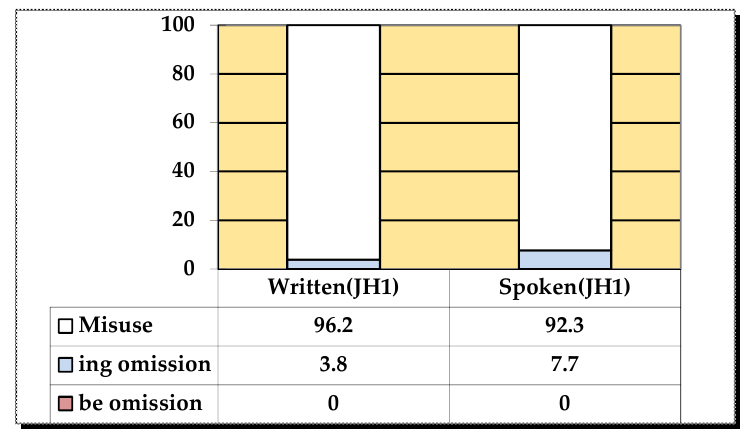
Figure 6. Misuse of bare verbs and 3SG − s in auxiliary be + − ing (%).